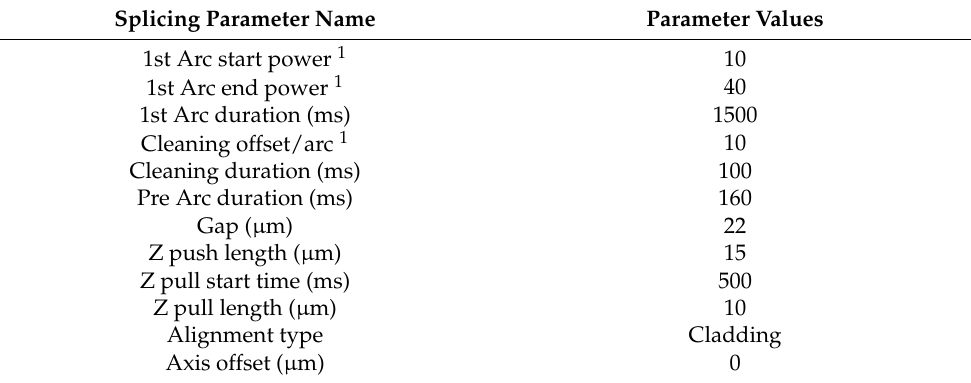
Table 3. Parameters of the splicing program (Fitel, model